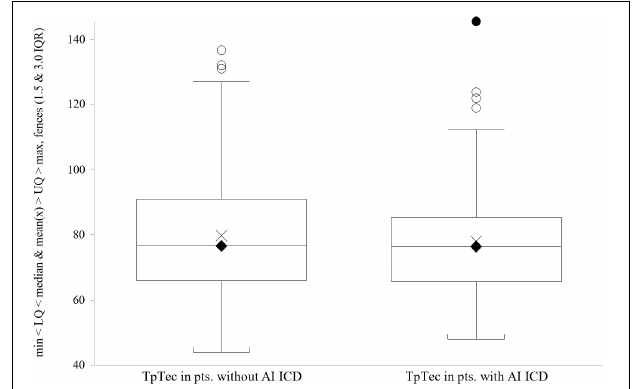
FIGURE 2 | TpTec interval in patients without/with appropriate ICD